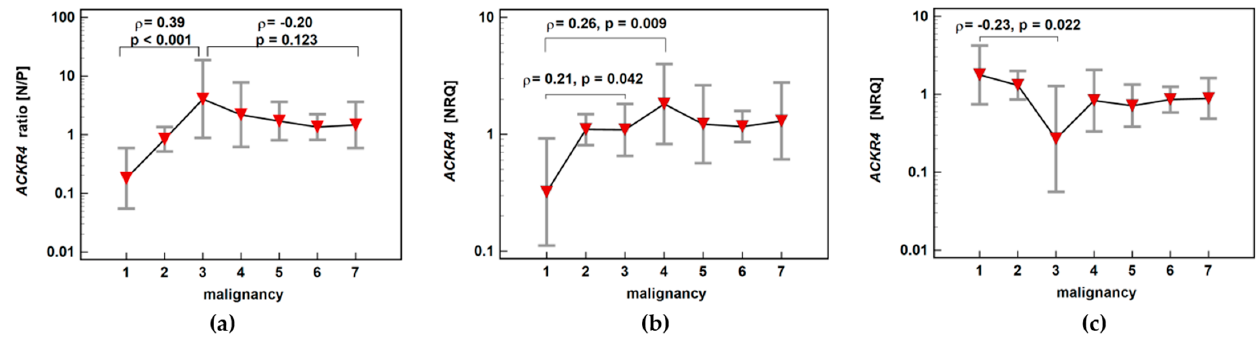
Figure 10. Impact of polyp risk for malignancy and cancer malignant potential on ( a ) ACKR4 expression ratio (normal-to-pathological) (N/P); ( b ) ACKR4 expression in normal mucosa; ( c ) ACKR4 expression in pathological tissue (adenoma or adenocarcinoma). Data presented as means with 95% confidence interval (red triangles with whiskers). The relationship was analyzed using Spearman rank correlation and expressed as correlation coefficient ρ . NRQ, normalized relative